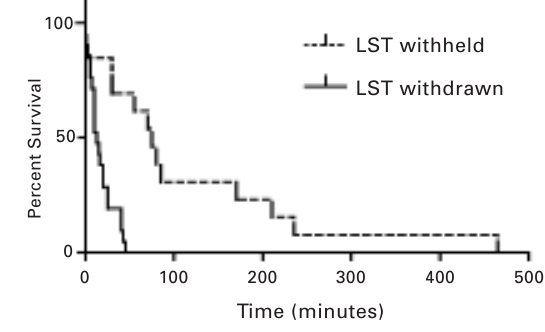
Figure 1 Survival curve of infants measured from the time a life- sustaining treatment was withdrawn (n = 21) or withheld (n = 13). (median survival time: 13 (25–75% = 6–25) min- utes vs 70 (25–75% = 27.5–147.5) minutes, ratio 5.76, CI